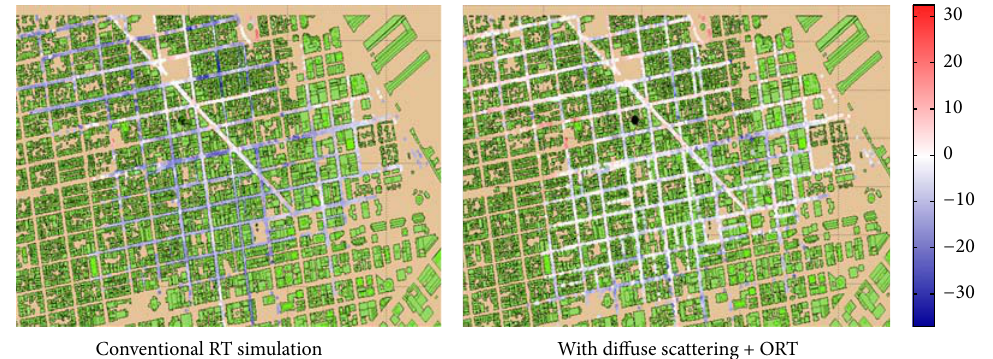
Figure 10: Comparison of RF coverage prediction error between conventional RT simulation (with ORT model included) and RT simulation with scattering combined with ORT; site A0002FFC.